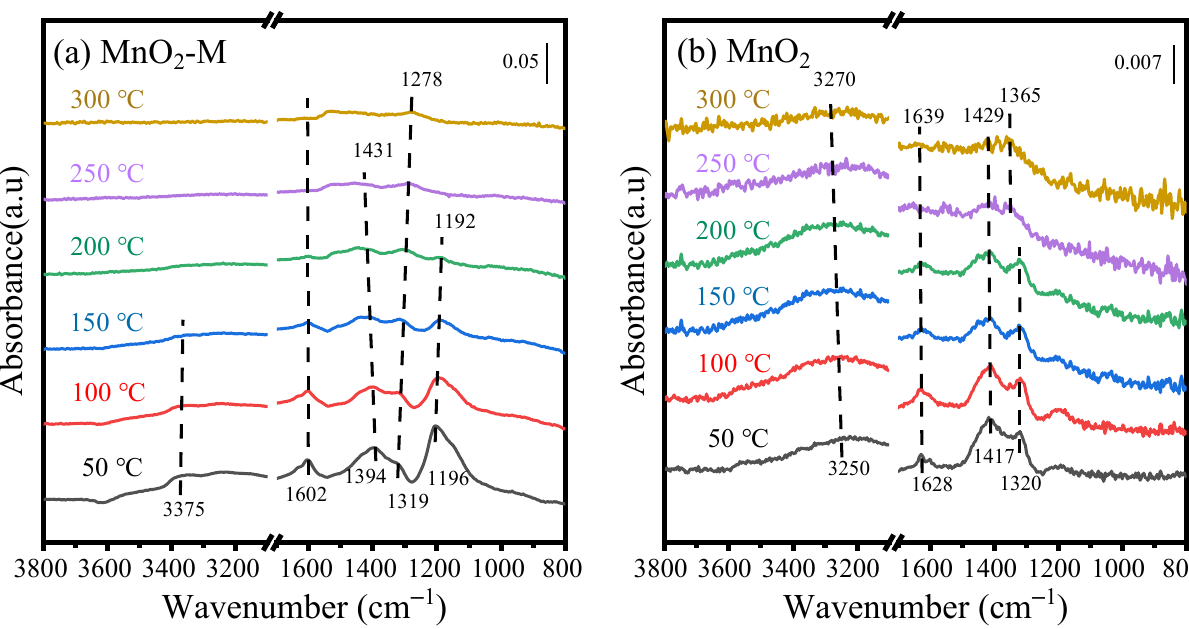
Figure 11. In situ DRIFTS spectra of adsorption of NO + O 2 + NH 3 at a different temperature over MnO 2 -M ( a ) and MnO 2 ( b ).